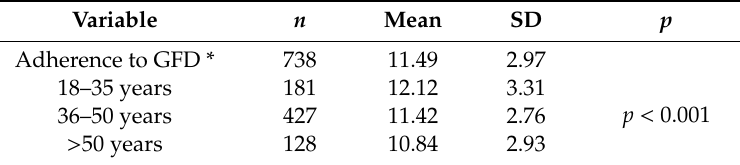
Table 2. CDAT total scores and divided according to age ( n = 738).